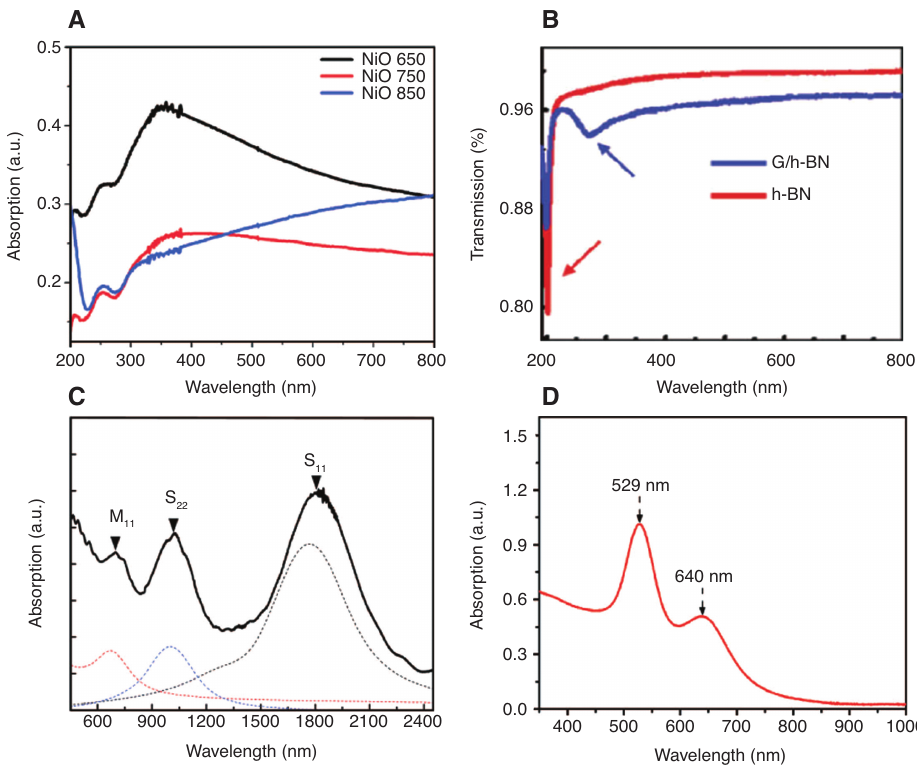
Figure 3: Representative linear optical responses of nanomaterials in visible spectral range. (A) Optical absorption spectra of NiO microrods at different temperatures. (B) UV-vis transmittance of G/h-BN (blue) and h-BN (red). (C) UV-vis-IR absorption spectrum of SWCNTs. (D) Linear absorption spectrum of an aqueous solution of Au NRs. (A) Reprinted from